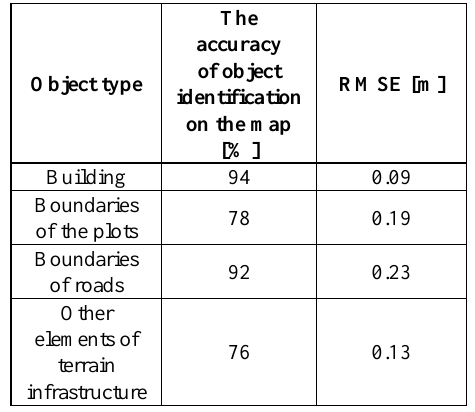
Table 3. The results of a comparative analysis of the ortho and basic map